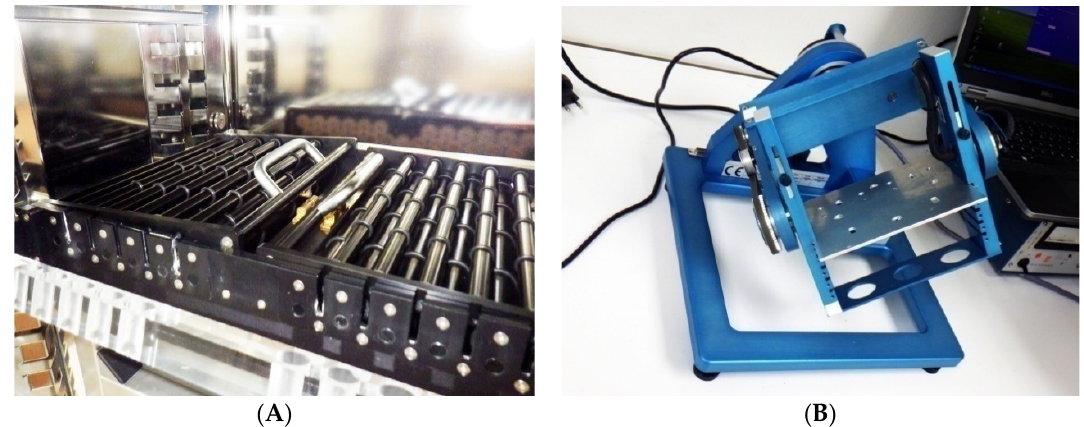
Figure A1. Simulated microgravity platforms: Microgravity simulation platforms (DLR) used as key experimental systems to simulate microgravity for suspension cell cultures: ( A ) Clinostat, ( B ) Random positioning machine.